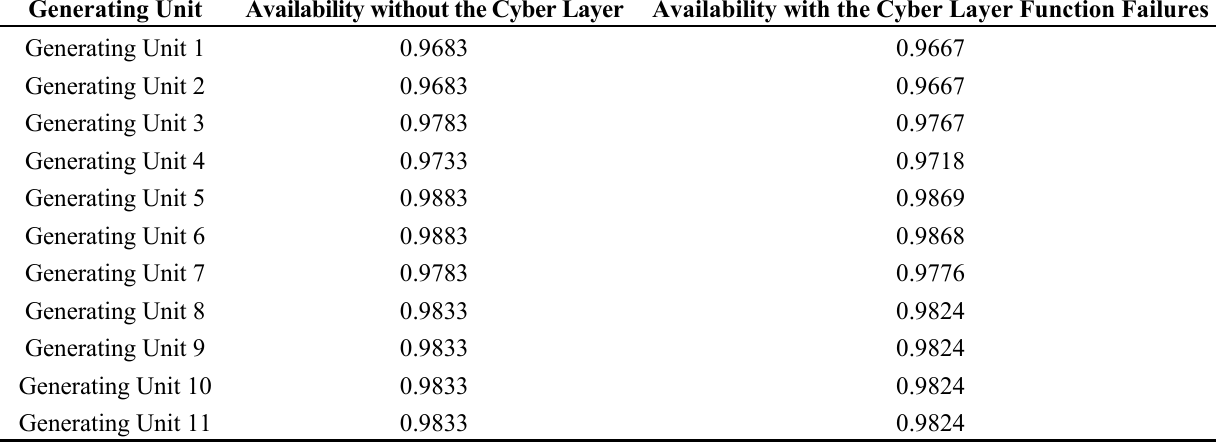
Table 5. The availability of generating units incorporating the cascading cyber layer function